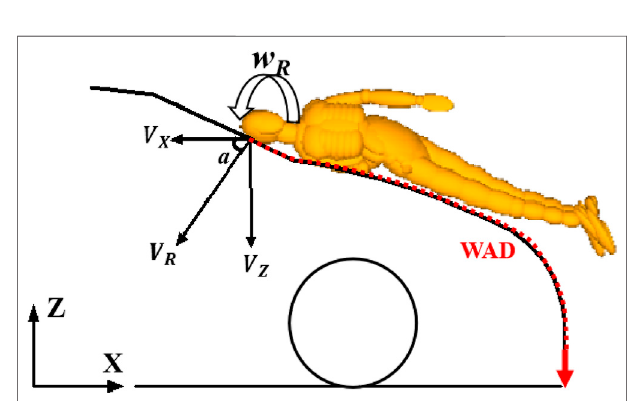
FIGURE 6 | De fi nition for parameters of pedestrian head-to-vehicle contact boundary condition.